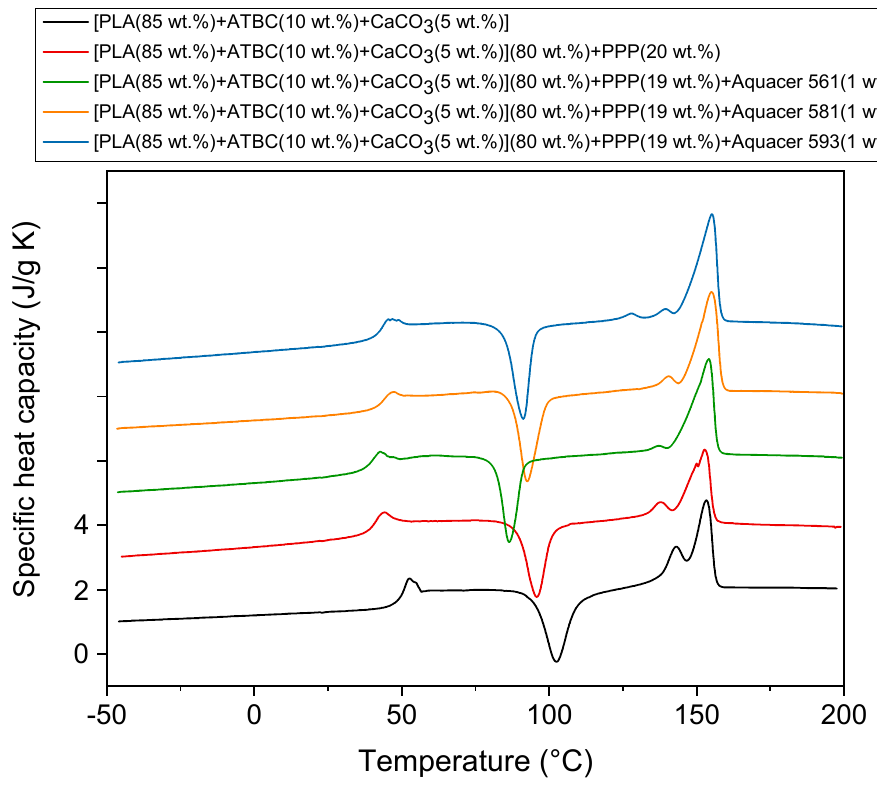
Figure 2. Specific heat capacity ( c p ) of the as prepared PLA based matrix and biocomposites indicated in the legend, as a function of the temperature. The curves were measured upon heating at 10 K/min after previous fast cooling to − 50 °C. The ordinate values refer only to the bottom curve. All the other curves are shifted vertically for the sake of clearness.